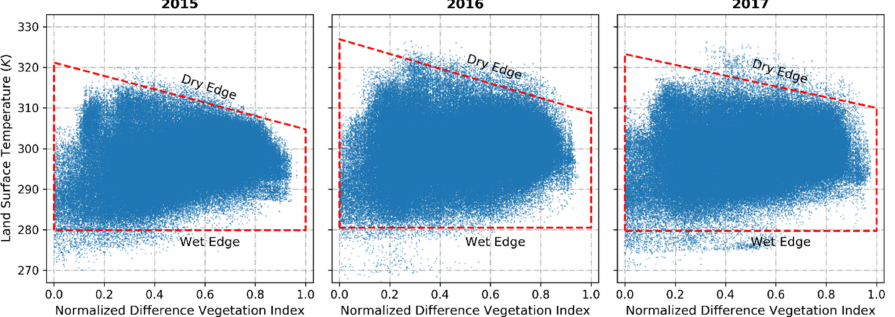
Figure 3. TVDI scatterplot in each